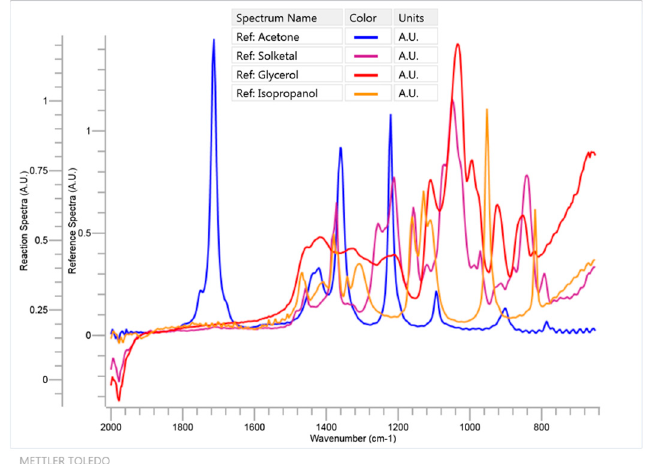
Figure 3. Time course as detected by Fourier Transform Infrared Spectroscopy (FTIR) at 1711 cm − 1 wavenumber for the reaction of glycerol and acetone to solketal and water using isopropanol as solvent (system 1, in red dashed line) together with negative blank to show no reaction between isopropanol and acetone (in green solid line).